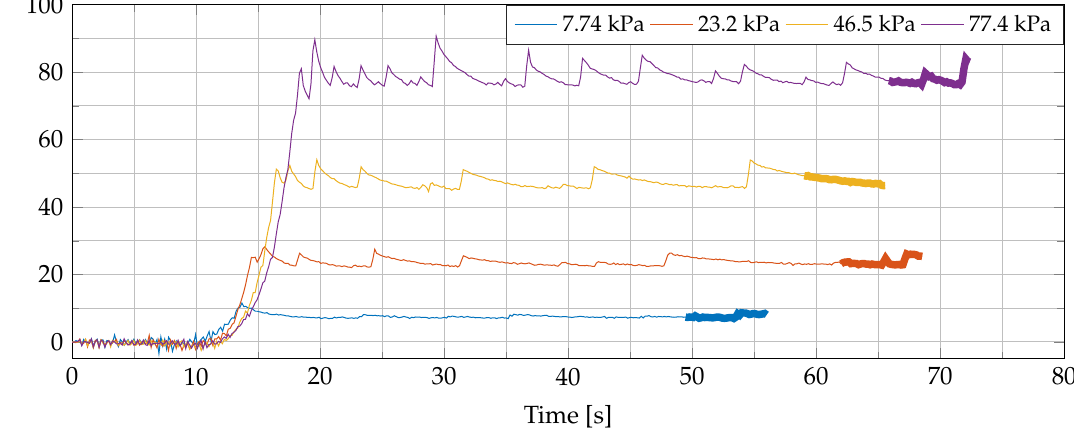
Figure 4. The measured pressure during four measurements of Experiment 5 with our PI-controlled pressure loop. The dielectric measurement is performed during the time span indicated as a thicker line.